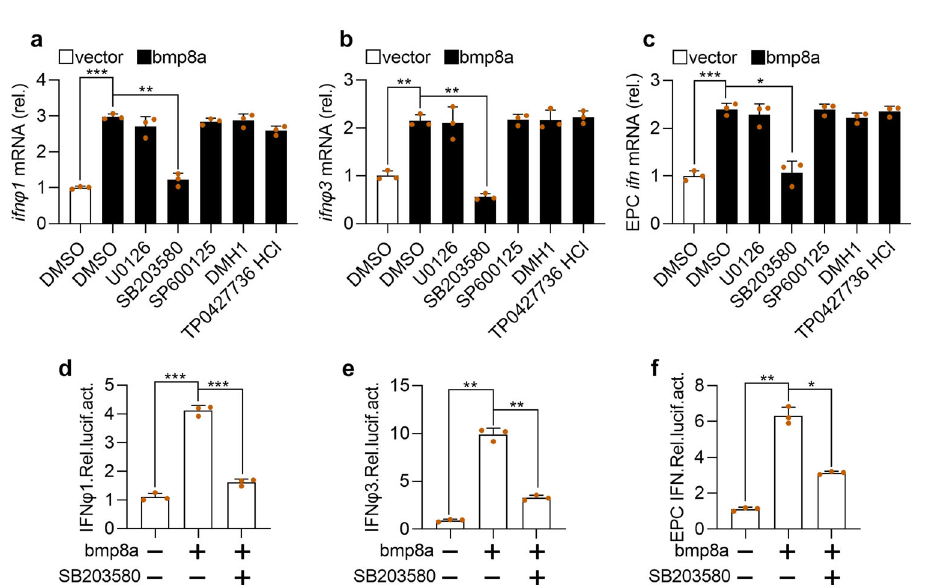
Fig. 4 Bmp8a promotes the IFN expression via p38 MAPK pathway. a , b Expression of ifn φ 1 ( a ) and ifn φ 3 ( b ) mRNA after transfected with bmp8a (2 μ g) in ZFL cells for 24 h, followed by treatment with SB203580, SP600125, U0126, DMH1, and TP0427736 HCl for another 24 h. c Similar as ( a , b ) but in EPC cells. The expression of zebra fi sh actb1 or EPC actin was used as an internal control for the qRT-PCR. d – f EPC cells were cotransfected with IFN φ 1pro-luc (200 ng, d ), IFN φ 3pro-luc (200 ng, e ) or EPC IFNpro-luc (200 ng, f ), pRL-TK (20 ng) together with bmp8a (200 ng) or empty vector (200 ng), respectively. At 24 h of post-transfection, cells were treated with or without SB203580 for another 24 h and then harvested for detection of luciferase activity. Renilla luciferase was used as the internal control. Data were from three independent experiments and were analyzed by Student ’ s t -test (two- tailed) for comparison of two groups or one-way ANOVA followed by Games – Howell post hoc tests for comparison of multiple groups. All data were presented as mean ± SD (* p < 0.05, ** p < 0.01, and *** p < GAS motifs were deleted, bmp8a promoter-driven luciferase activities were reduced even more signi fi cantly (Fig. 8d, e). These suggested that both Stat1a and Stat1b may interact with the GAS motifs.